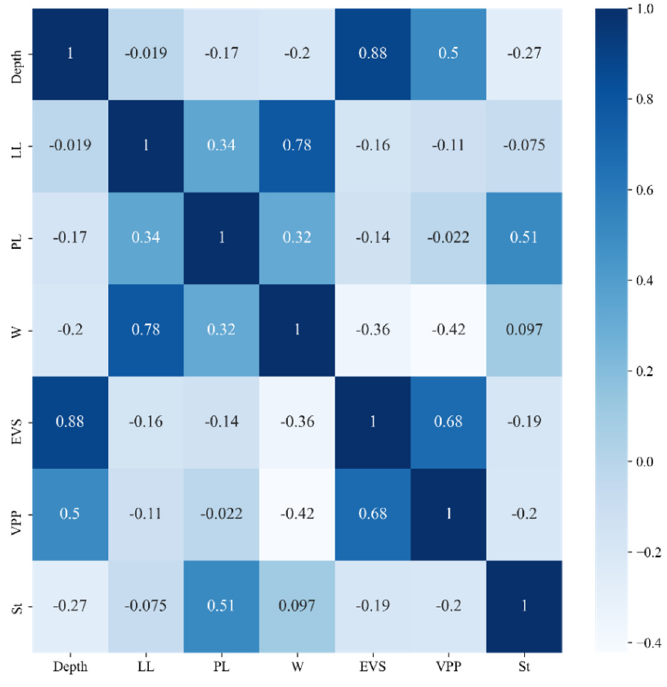
Figure 4. Heat map of clay parameters.